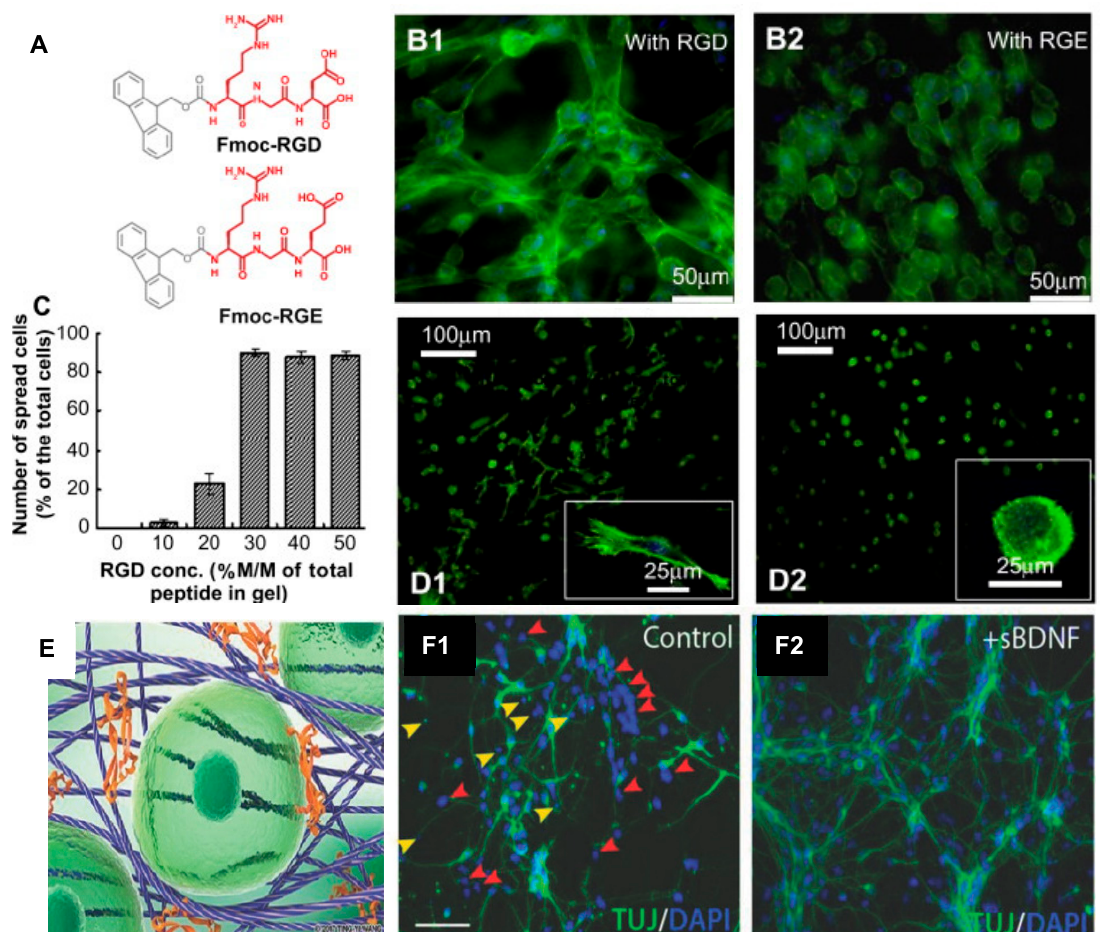
Figure 3. Biocompatibility of self-assembling peptide hydrogels . The Fmoc-FF/RGD hydrogel promotes cell adhesion with subsequent cell spreading and proliferation. ( A ) The structures of the two chemical analogs: Fmoc-RGD and Fmoc-RGE. ( B ) Cell adhesion and morphology in the Fmoc-FF/RGD and Fmoc-FF/RGE hydrogels: ( B1 ) human adult dermal fibroblasts (HDFa) are well-spread in the Fmoc-FF/RGD hydrogels and form a three-dimensional cell network 48 h post culture; ( B2 ) HDFa in the Fmoc-FF/RGE hydrogels maintains a round morphology after 48 h. ( C ) The Fmoc-RGD concentration also influenced cell spreading; in the hydrogels with 30–50% Fmoc-RGD incorporated, adequate cell spreading occurs with over 90% spread cells. ( D ) Integrin blocking experiments proved direct interaction of the cells with RGD after 20 h: ( D1 ) Cells with unblocked α 5 β 1 integrins were able to spread and directly attach to the RGD sites on the nanofibres. ( D2 ) Cells with blocked α 5 β 1 integrins were unable to attach to the RGD sites and remained rounded. ( E ) Fmoc-DDIKVAV nanofibres interact with one another, forming a nanofibrous network, into which proteins such as the brain-derived neurotrophic factor (BDNF) (orange) can be shear-encapsulated to sustain delivery, thereby providing structural and chemical support for cells (green). ( F1 ) Representative cortical primary cultures illustrating total DAPI labelled cells and proportionate TUJ+ neurons under control conditions and following ( F2 ) soluble brain-derived neurotrophic factor (sBDNF) treatment. Note the increase in pyknotic nuclei (yellow arrows), as well as DAPI+ cells failing to adopt a TUJ+ neuronal fate (red arrows) in the absence of BDNF. Scale bar 100 µm. ( A – D ) Adapted with permission from Zhou et al. 2009 Copyright Elsevier [110]. ( E , F ) Adapted with permission from Nisbet et al. 2018 Copyright Wiley-VCH [171].